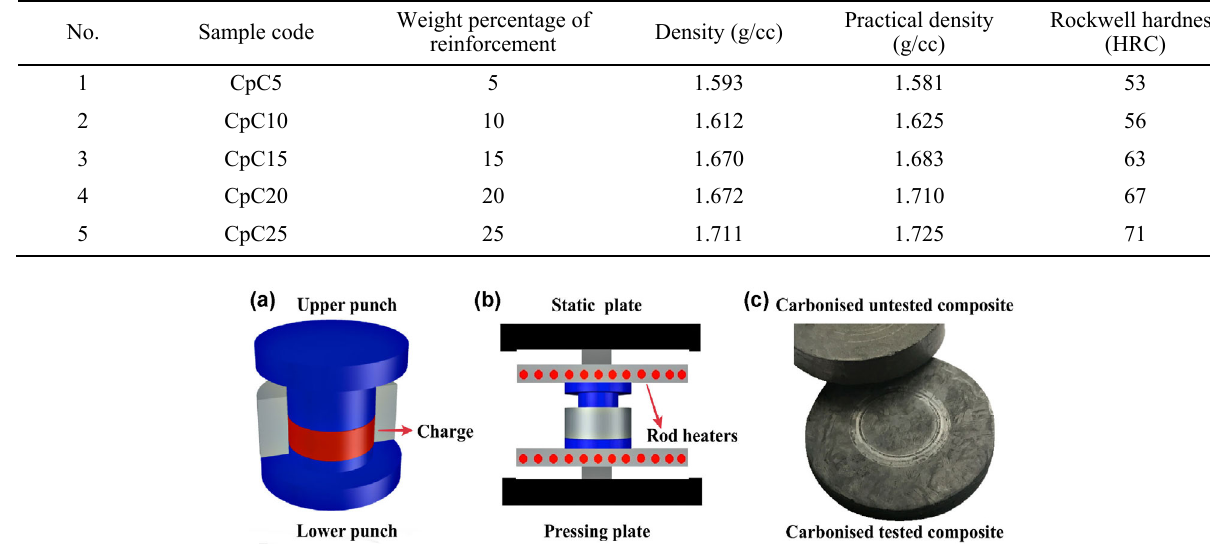
Table 1 General characteristics of fabricated carbon carbon composites.